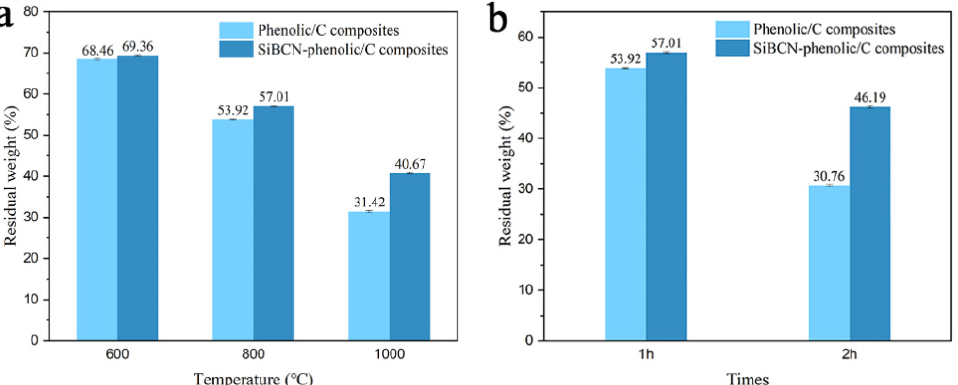
Figure 7. Residual weight of phenolic/C composites and SiBCN–phenolic/C composites at differ- ent temperatures for 1 h ( a ); residual weight of phenolic/C composites and SiBCN–phenolic/C composites at 800 °C for different times ( b ).